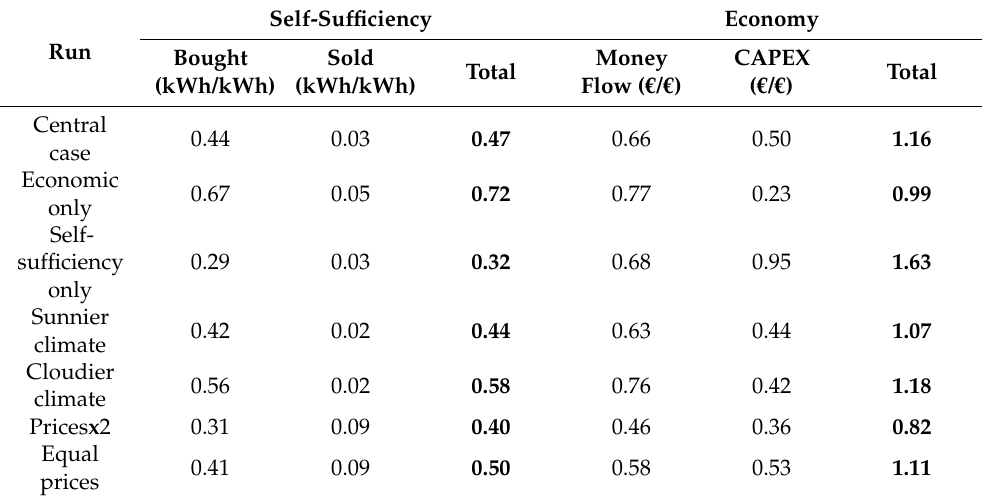
Table 5. Final performance in case 1.